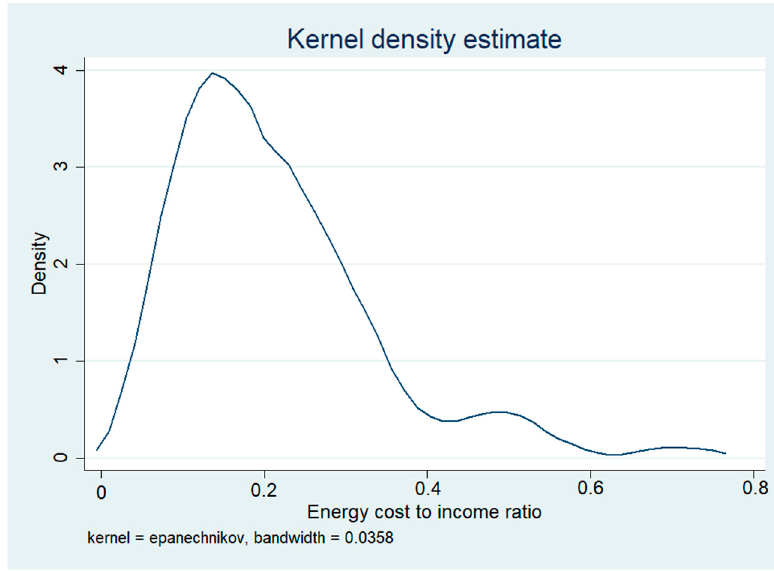
Figure 4. Kernel density histogram of energy expenditure to income ratio.